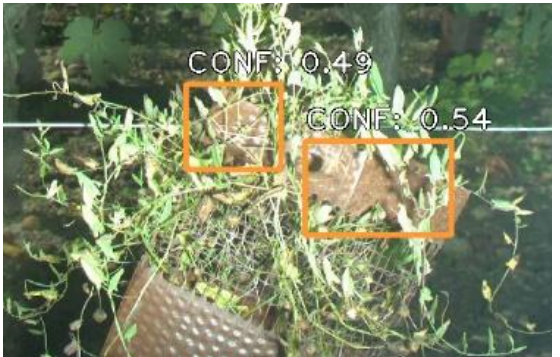
Figure 9. Extract of an image from the ADVANTAGE esca detection dataset showcasing false detections of dried leaves (orange boxes). Numbers indicate the algorithm confidence.